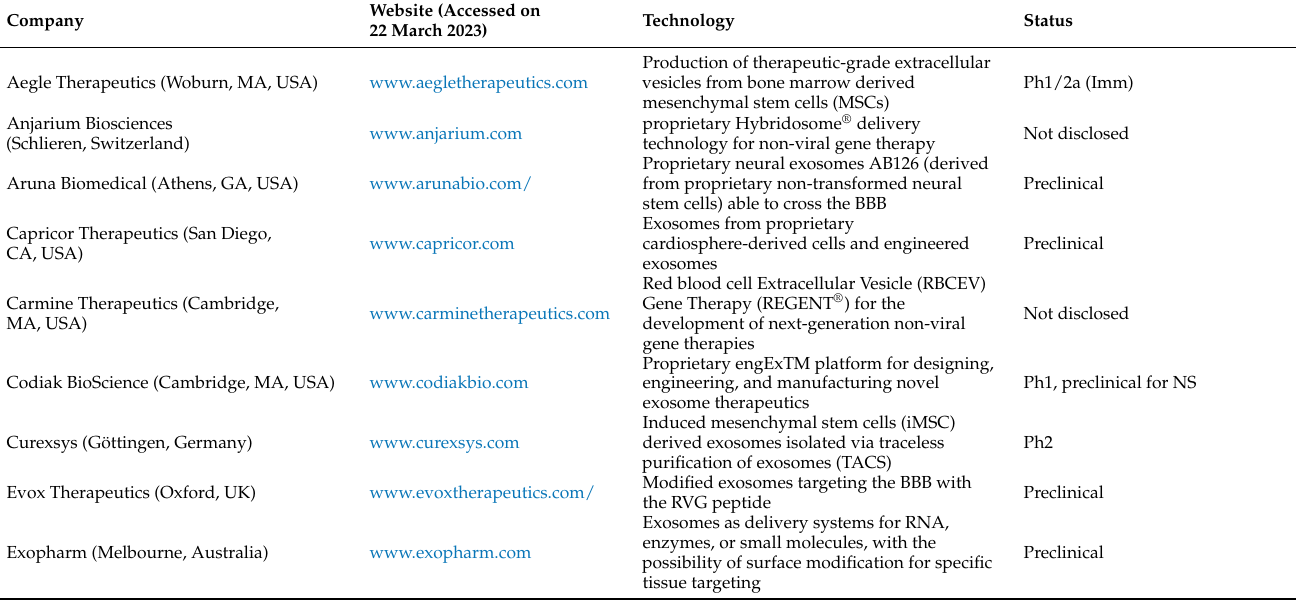
Table 3. Companies Developing Exosome